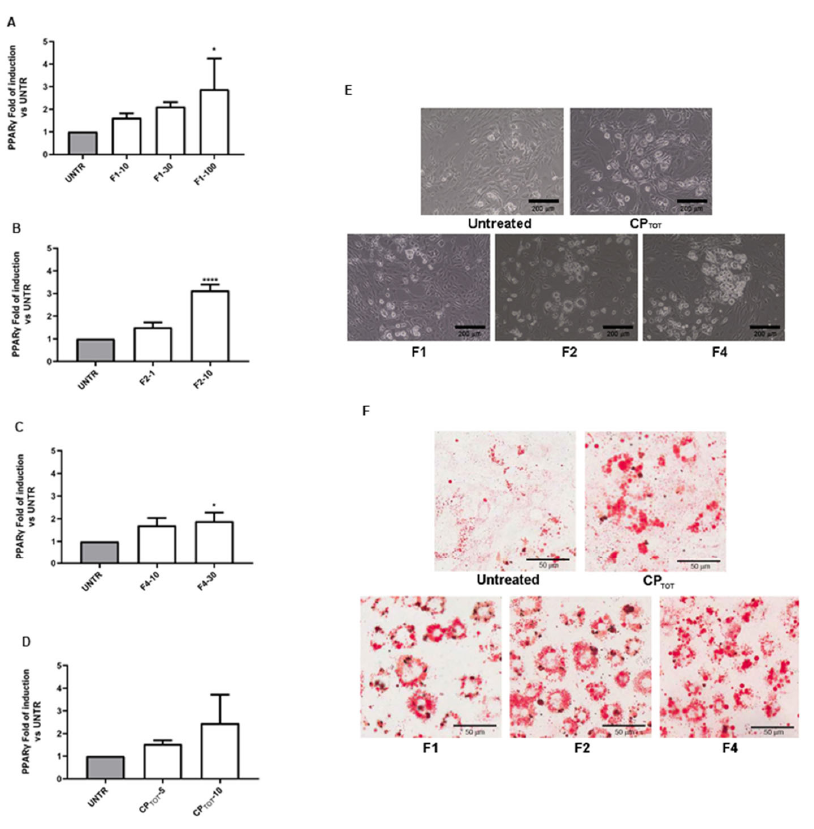
Figure 2. Effect of CP fractions and total extract on adipocyte differentiation. PPAR γ mRNA level was evaluated, after the complete differentiation time, on 3T3-L1 cell line left untreated (UNTR) or treated with fractions 1, 2, and 4 (F1, F2, F4) or with the total extract (CP TOT ) at different concentrations ( µ g/mL) ( A – D ). Data are reported as mean ± SEM of at least three independent experiments performed in duplicate. * p < 0.05, **** p < 0.0001. Representative contrast phase images ( E ) and Oil Red O-stained cell images ( F ) in the same experimental conditions were shown, respectively. Magnification 20 ×